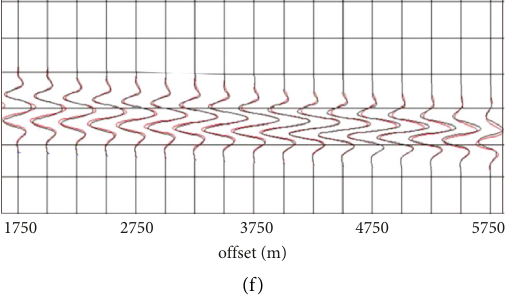
Figure 4: The synthetic tests: (a) target model with alternating low and high velocity anomalies; (b) the travel time tomography results; (c) the inverted model of the L2-norm EWI; (d) the inverted model of the W2-norm EWI; (e) waveform fitting of early arrival between the synthetic data (red) and observed data (black) for the L2-norm EWI; (f) waveforms fitting of early arrival between the synthetic data (red) and observed data (black) for the W2-norm